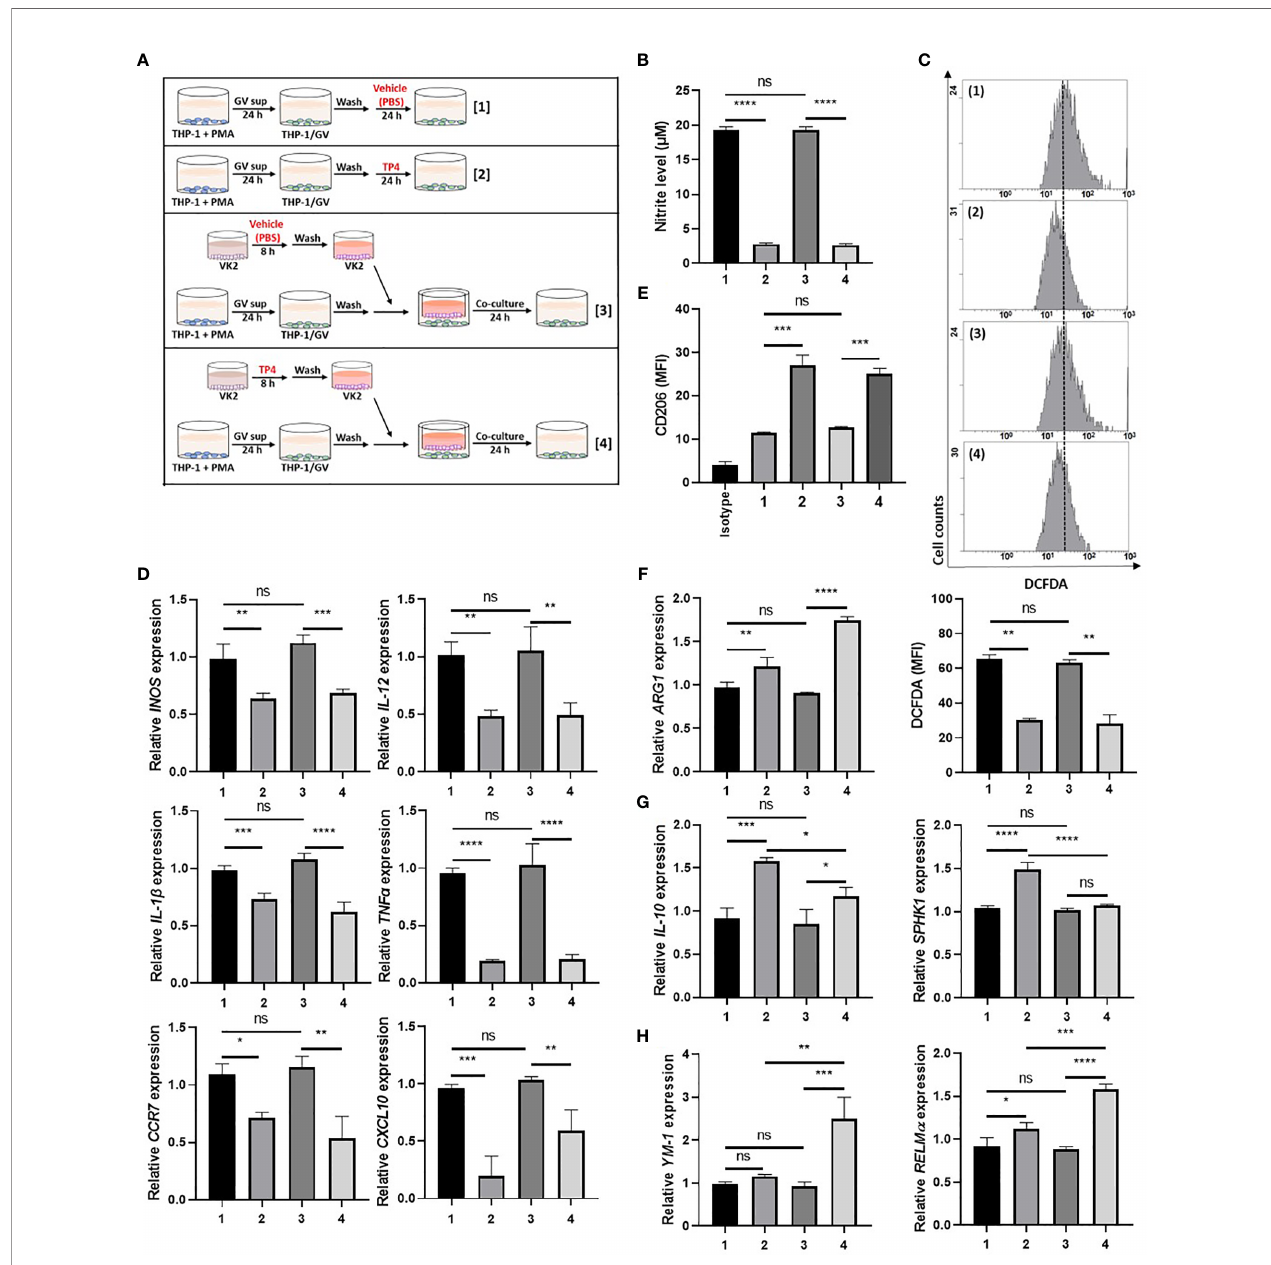
FIGURE 3 | TP4 induces M2 phenotypes in THP-1/GV cells. (A) Schematic description of the TP4 treatment methods for THP-1/GV cells. PMA (phorbol 12- myristate 13-acetate)-differentiated THP-1 cells were stimulated with 10% (v/v) G. vaginalis -free culture supernatants (GV sup) for 24 h. After incubation, THP-1/GV cells were washed with PBS and treated with [treatment 1] vehicle (PBS) or [treatment 2] TP4 (7.82 µg/ml) for 24 h or co-cultured with VK2 cells which had been pre-treated with [treatment 3] vehicle (PBS) or [treatment 4] TP4 (7.82 µg/ml) on cell culture inserts for 8 h and then replaced with fresh culture medium. (B) The nitric oxide (NO) levels in THP-1/GV cells were assayed by the NO assay. (C) The reactive oxygen species (ROS) levels in THP-1/GV cells were measured by the DCFDA assay using fl ow cytometry. The mean fl uorescence intensity (MFI) is shown in bar graphs. (D) Gene expression levels of M1-related genes ( INOS, IL-12, CCR7, CXCL10, TNF a , and IL-1 b ) were measured by qRT-PCR. Data were represented the normalized target gene amount relative to the group of treatment 1. (E) Macrophage surface marker (CD206) was detected by fl ow cytometry; the MFI is shown. The black bar graph indicates isotype controls. (F) ARG1 expression was measured by qRT-PCR. Data were represented the normalized target gene amount relative to the group of treatment 1. (G) Gene expression levels of M2c-related genes ( IL-10 and SPHK1 ) were measured by qRT-PCR. Data were represented the normalized target gene amount relative to the group of treatment 1. (H) Gene expression levels of M2a-related genes ( YM-1 and RELM a ) were measured by qRT-PCR. Data were represented the normalized target gene amount relative to the group of treatment 1. Data are presented as mean ± SD of three independent experiments (* P < 0.05; ** P < 0.01; *** P < 0.001; **** P < 0.0001; ns, not statistically signi fi